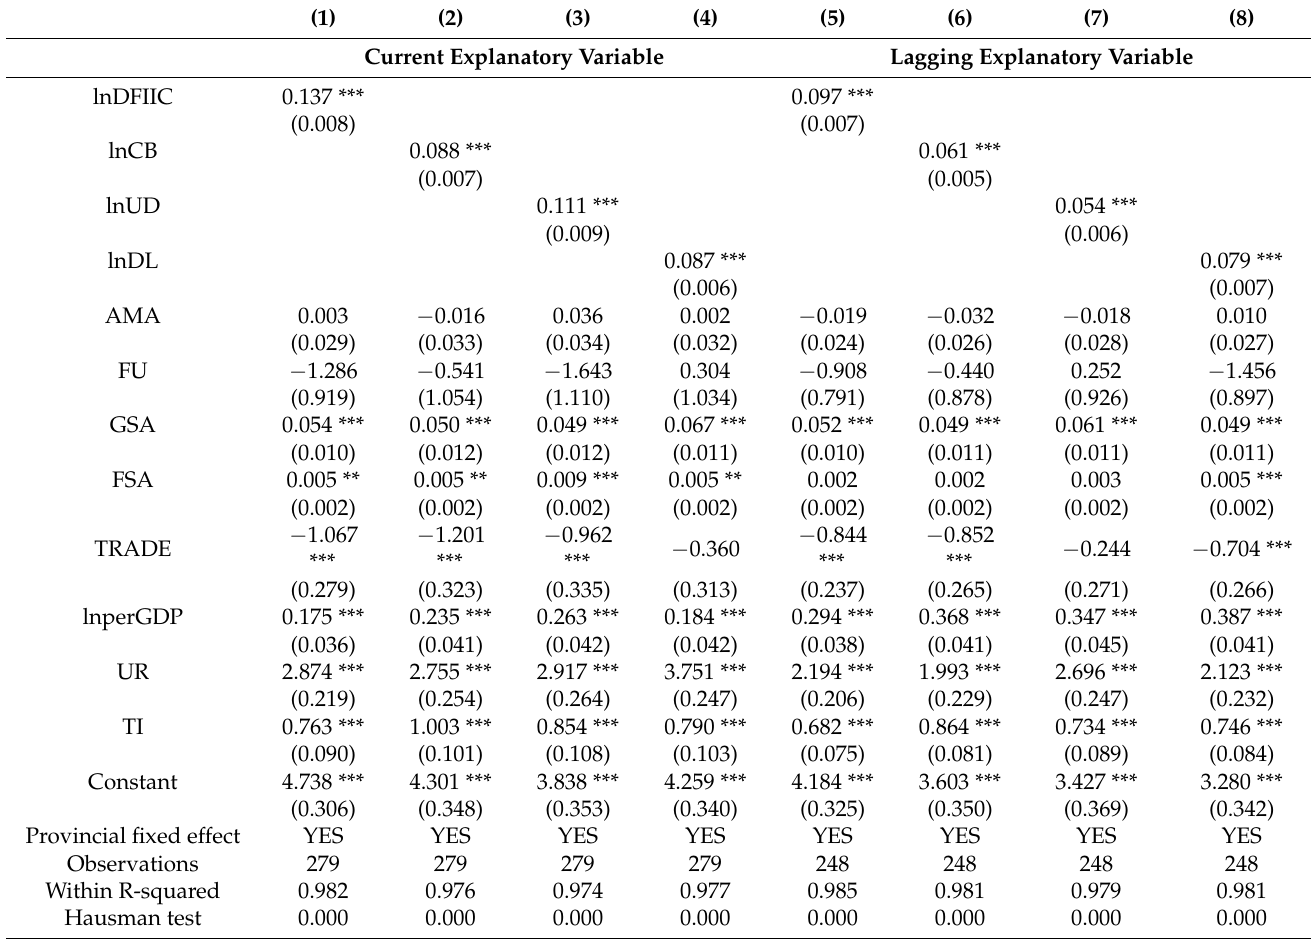
Table 3. Impact of inclusive digital finance on rural resident income